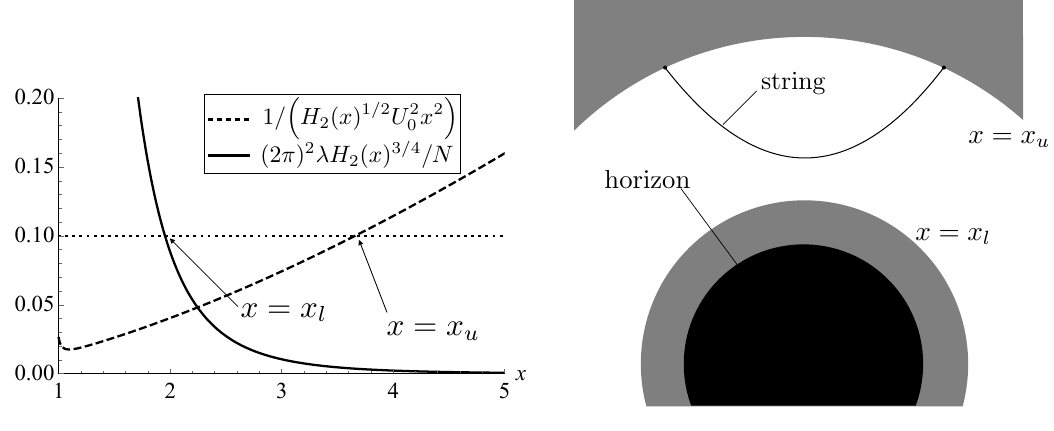
Figure 2 . Left: plot of the left hand sides of (2.11) and (2.12), for N = 456 and ~ T = 0 : 02. A larger N results in a wider region in x . Right: valid spacetime region (White) and our probe string con(cid:12)guration. The shaded regions are excluded for use as the string perturbation breaks